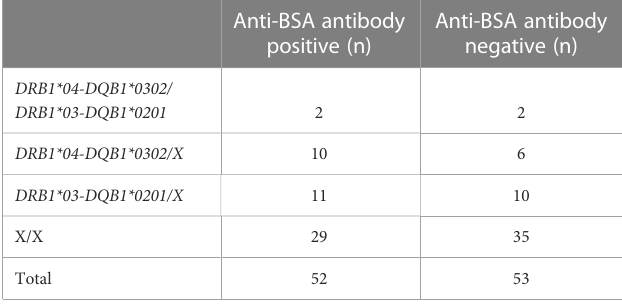
TABLE 1 The frequency of high risk HLA haplotypes for type 1 diabetes were similar in individuals with DS with increased levels of anti-BSA antibodies. Anti-BSA antibody Anti-BSA antibody positive (n) negative